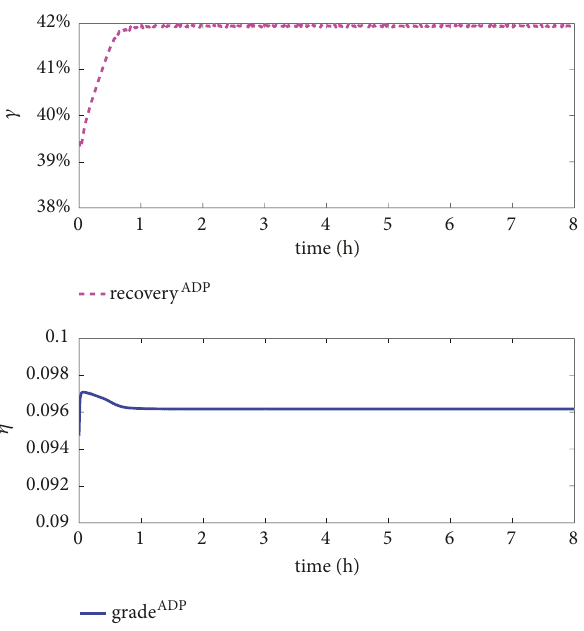
Figure 23: Recovery and grade trajectories in Task 2.